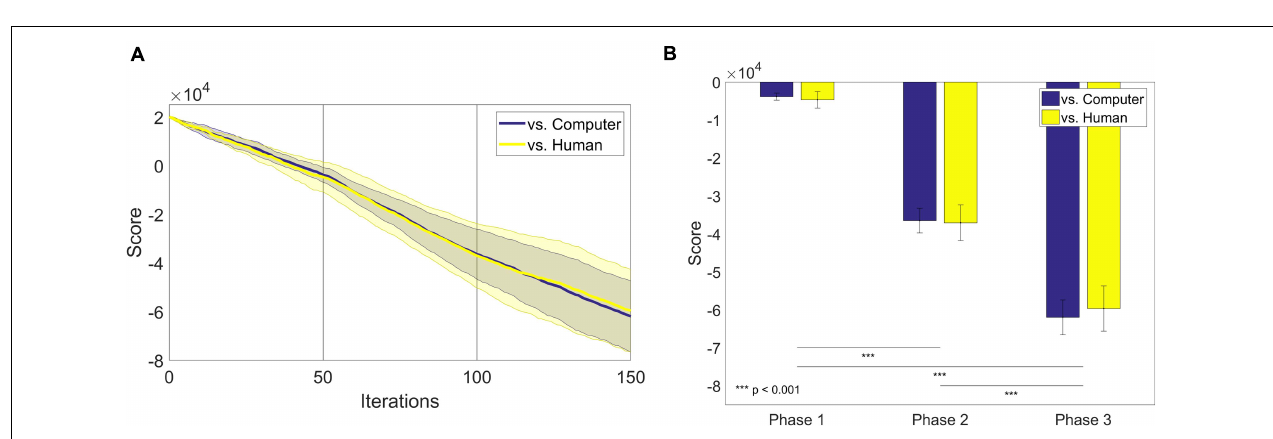
FIGURE 3 | The behavioral patterns over one hundred fifty iterations during the chicken game of all eighteen participants. In the top panel are the patterns of the group knowing they played against a computer opponent and in the bottom panel are those of the group knowing they played against a human opponent. The left column in each pattern represents the artificial agent’s behavior (C) and the right column represents that of the human player (H). The temporal order of iterations starts from the top to the bottom rows in each pattern. The black pixel denotes rush and the orange one denotes avoid actions. The red lines divide the iterations into three phases: the agent played by exchanging turns of rush/avoid (1–50 iterations); by rushing (51–100); and by exchanging again (101–150).